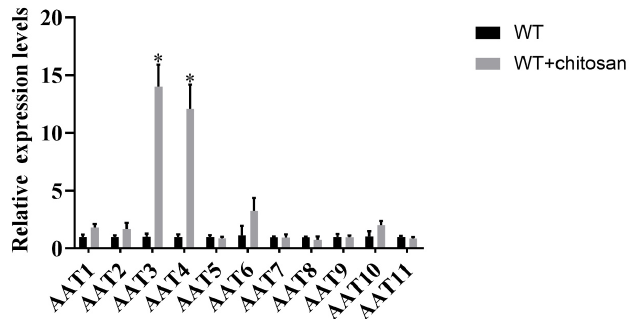
Figure 5. Gene screening of amino acid transporters treated with chitosan. The transcriptional levels of each AAT gene in WT strain were detected after chitosan treatment. The results are presented as mean ± standard deviation, and the asterisk indicates that there was a significant difference between the experimental group and the control group, * p < 0.01.